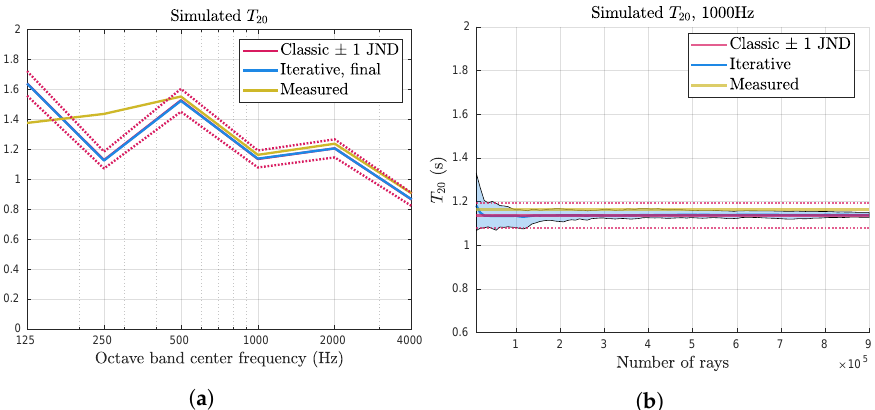
Figure 9. Reverberation time T 20 measured and obtained from simulations using the classic and the iterative algorithm. Dashed lines indicate values 1 JND away from the results from the classic ray tracer. In ( a ), the results for the maximum number of rays are shown. ( b ) shows the estimate for 1000 Hz using an increasing number of rays in the iterative algorithm, as well as the results for the full classic simulation. The shaded area illustrates the spread of estimates in the iterative